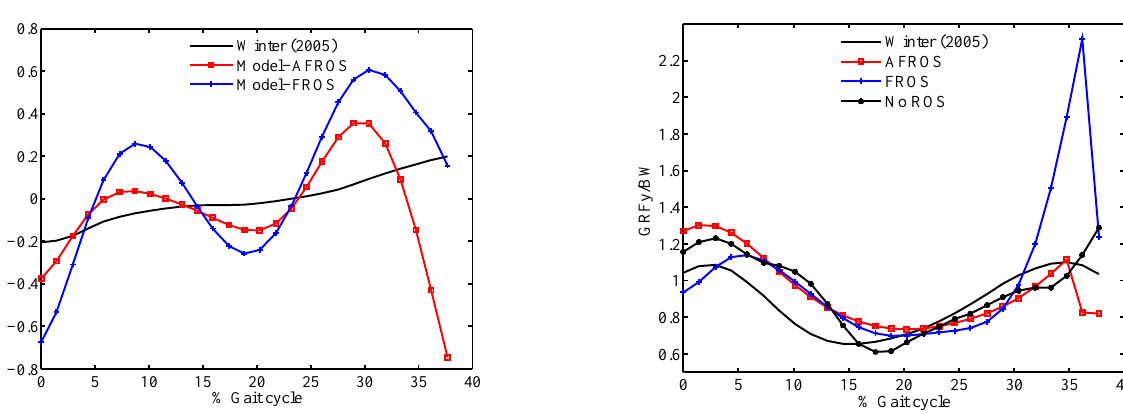
Figure 15. GRFy results for SS phase – experimental data (Winter, 2005) and results using rolling foot models and without using any ROS model. (Gait cycle starts at toe-off of the other leg, that is, at the beginning of